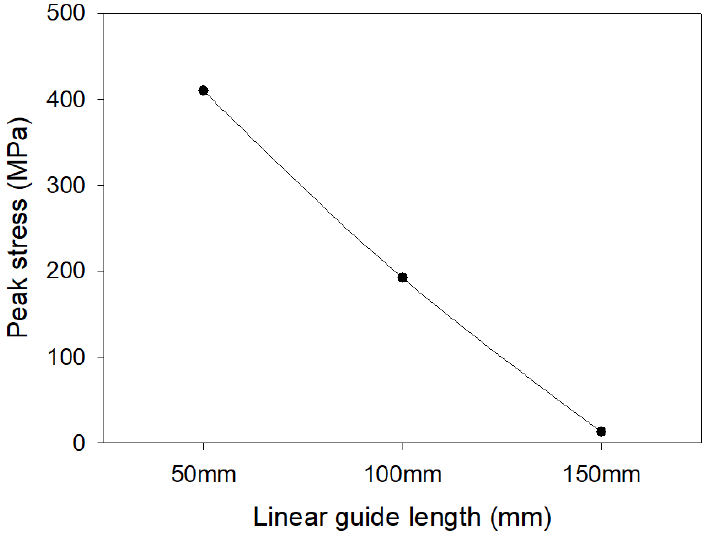
Figure 35. Relationship of linear guide length to maximum stress applied to the curtain wall.